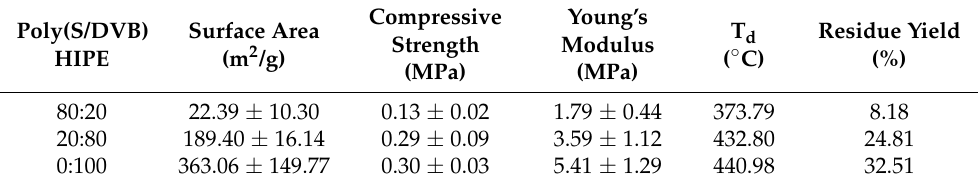
Table 1. Physical, mechanical, and thermal properties of poly(S/DVB)HIPEs prepared using a different S/DVB